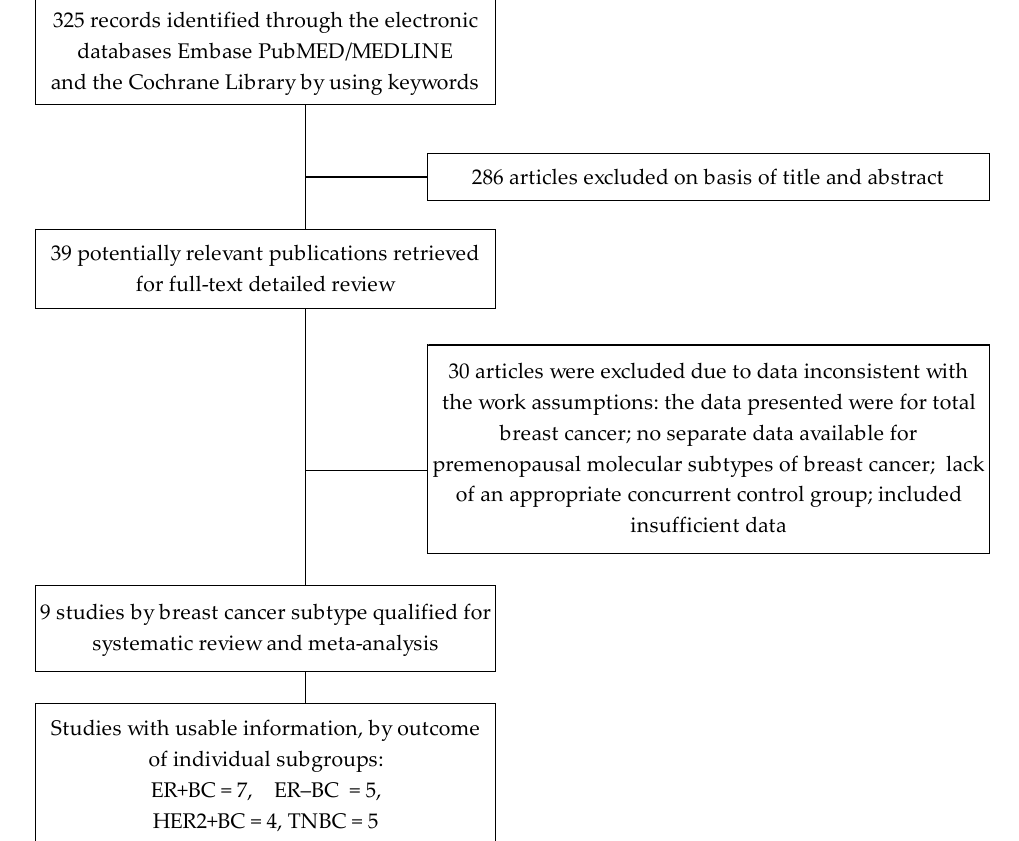
Figure 1. Flow diagram of literature search and research selection procedure.